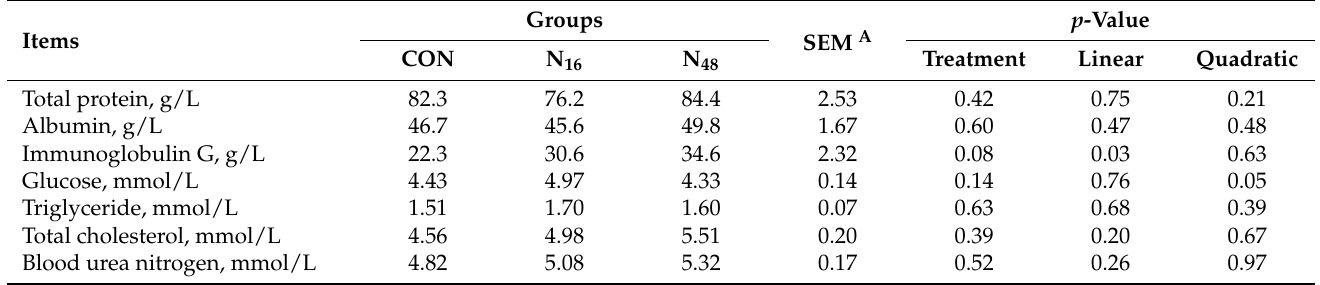
Table 2. Effects of the fruit from Nitraria tangutorum (FNT) supplement on serum biochemical variables in Hu rams.